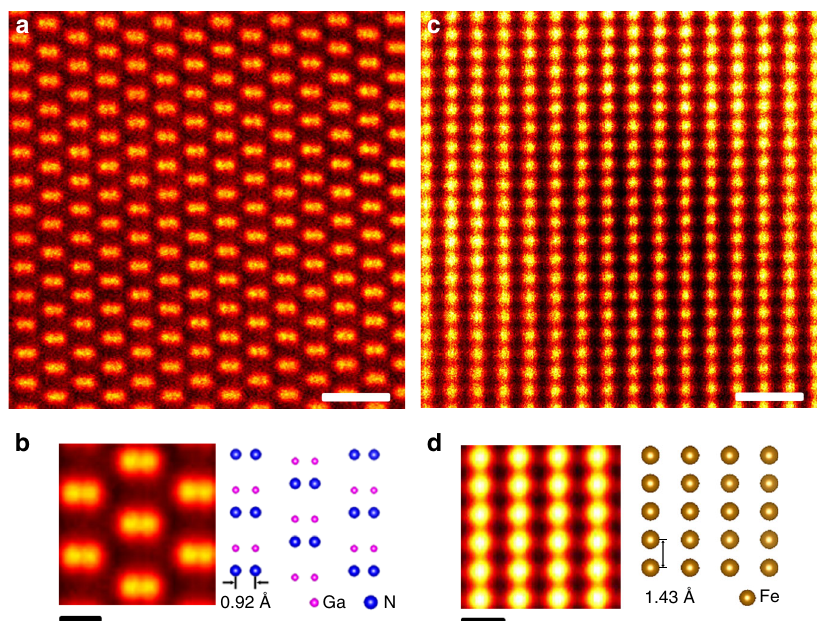
Fig. 3 Atomic-resolution ADF STEM images of non-magnetic and magnetic crystals in a magnetic fi eld-free environment. a Experimental ADF STEM image of a GaN single crystal observed along the [111] direction. Scale bar indicates 0.5 nm. This image is cropped from the averaged image of very fast scan STEM images acquired in ten sequential frames, each containing 512 × 512 pixels at a dwell time of 5 μ s/pixel followed by image fi ltering with the radial difference fi lter 18 , released by the HREM Research, in order to remove background noise. b Experimental repeat-unit averaged image from the ADF STEM image and the crystal structure model of GaN projected along the [111] direction. Scale bar indicates 0.2 nm. The crystal structure model was drawn using the VESTA software 19 . Ga-Ga dumbbells of 0.92 Å separation are well resolved. c Experimental ADF STEM image of Fe-3%Si observed along the [110] direction. Scale bar indicates 0.5 nm. This image is cropped from the averaged image of very fast scan STEM images acquired in ten sequential frames, each containing 512 × 512 pixels at a dwell time of 4 μ s/pixel. d Experimental repeat-unit averaged image from the ADF STEM image and the crystal structure model of Fe-3%Si projected along the [110] direction. Scale bar indicates 0.2